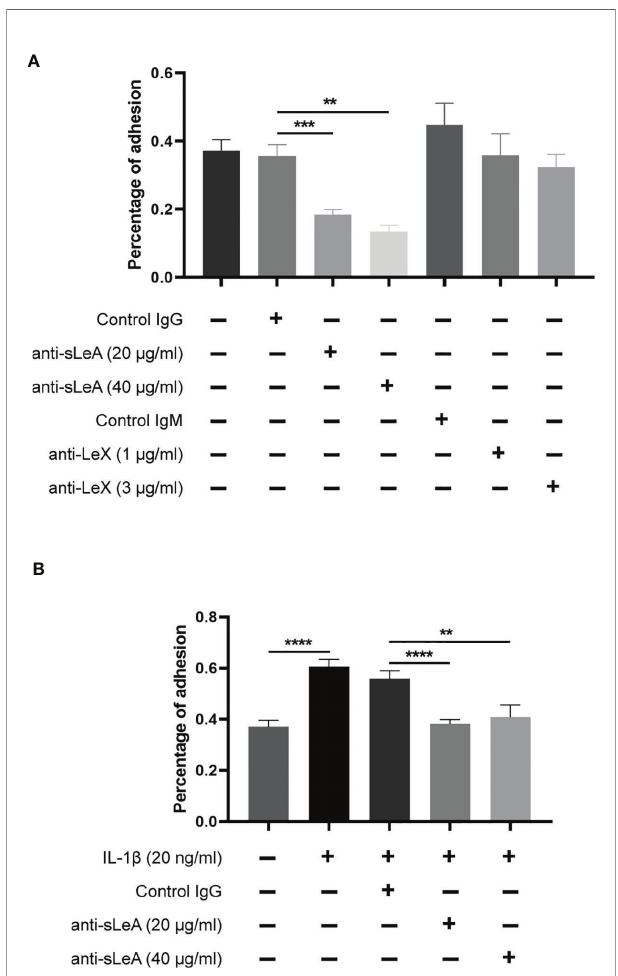
FIGURE 7 | Antibody blockade and IL-1 b stimulated in vitro implantation assay. (A) RL95-2 monolayer cells were pretreated with different concentrations of anti-sLeA/LeX antibody or negative control IgG/M antibody for 1 h before co-culture. The total number of transferred spheroids in each well was fi rstly counted, then nonadherent spheroids were aspirated off, washed with DPBS twice and the number of attached spheroids was counted again under microscope. The results were presented as percentage of adhesion spheroids. Anti-sLeA antibody signi fi cantly suppressed the spheroids attachment, while anti-LeX antibody only slightly suppressed the attachment but the difference was not prominent. (B) RL95-2 cells were continuously cultured at the presence of IL-1 b (20ng/ml) for 4 d before the in vitro implantation and blockade assay. IL-1 b treatment markedly increased the trophoblast spheroids attachment, and the induced attachment could be dramatically suppressed by anti-sLeA antibody. Statistical analysis was performed in three independent experiments by t test. Error bars, S.E.M. ** P < 0.01, *** P < 0.001, **** P <